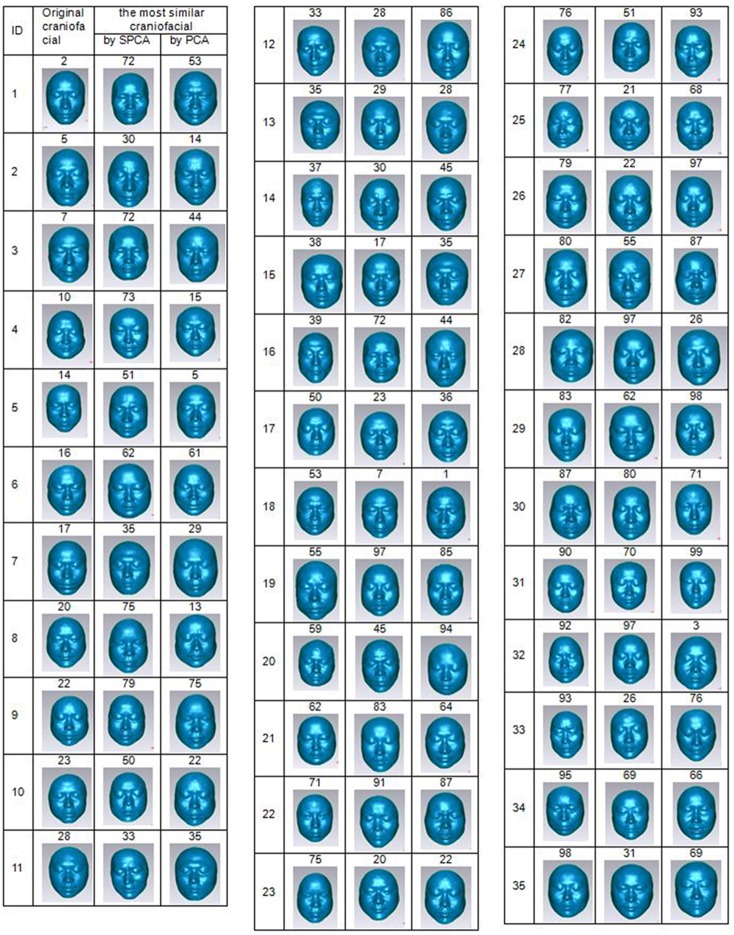
Comparison of the closest craniofacial data found by SPCA and PCA.